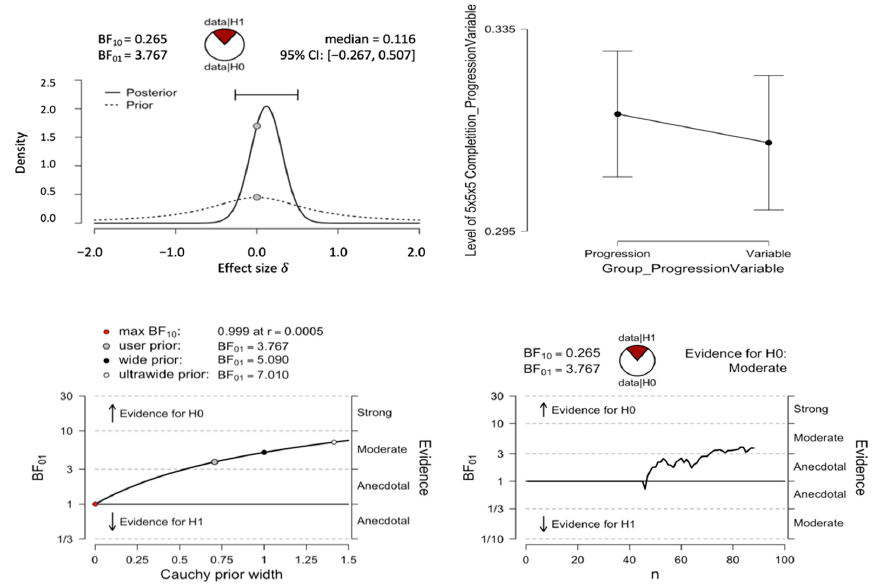
Figure 6. Results of Bayesian t -test for the progression-order and variable-order conditions. The top-left pane shows prior and posterior densities. The top-right pane shows the descriptive plot. The bottom-left pane shows the Bayes Factor Robustness check. The bottom-right pane shows the sequential analysis.